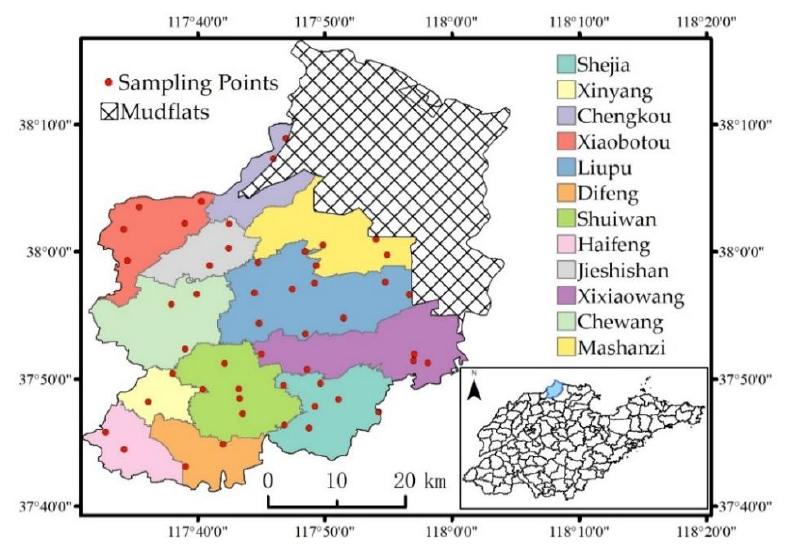
Figure 1. Overview of the study